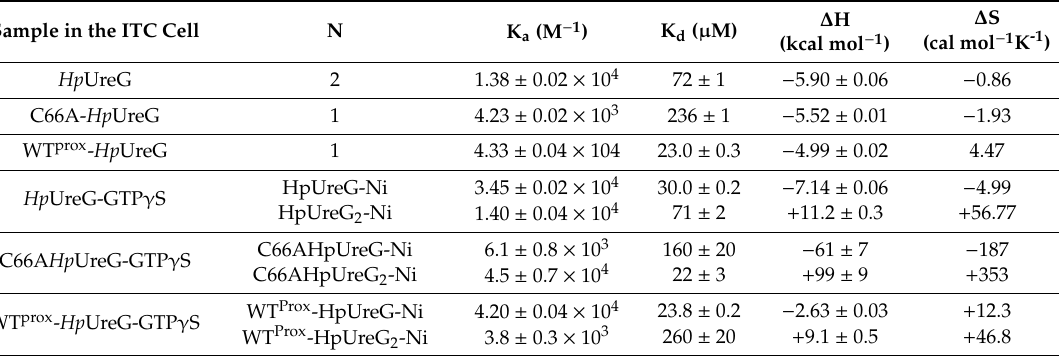
Table 1. Thermodynamic parameters of Ni(II) titrations over Hp UreG and its variants, in the absence and in the presence of GTP γ